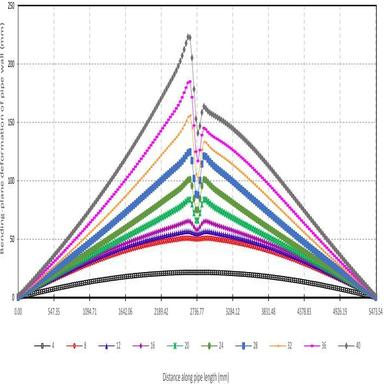
Evolution of wrinkle deformation for full-length pipe model.